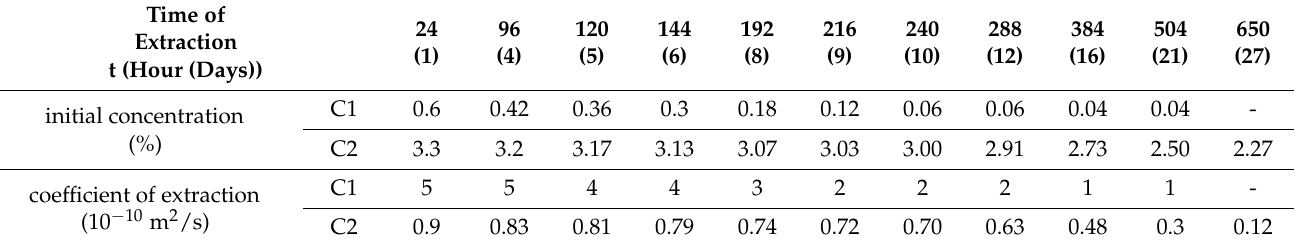
Table 2. Numerical modeling of the extraction